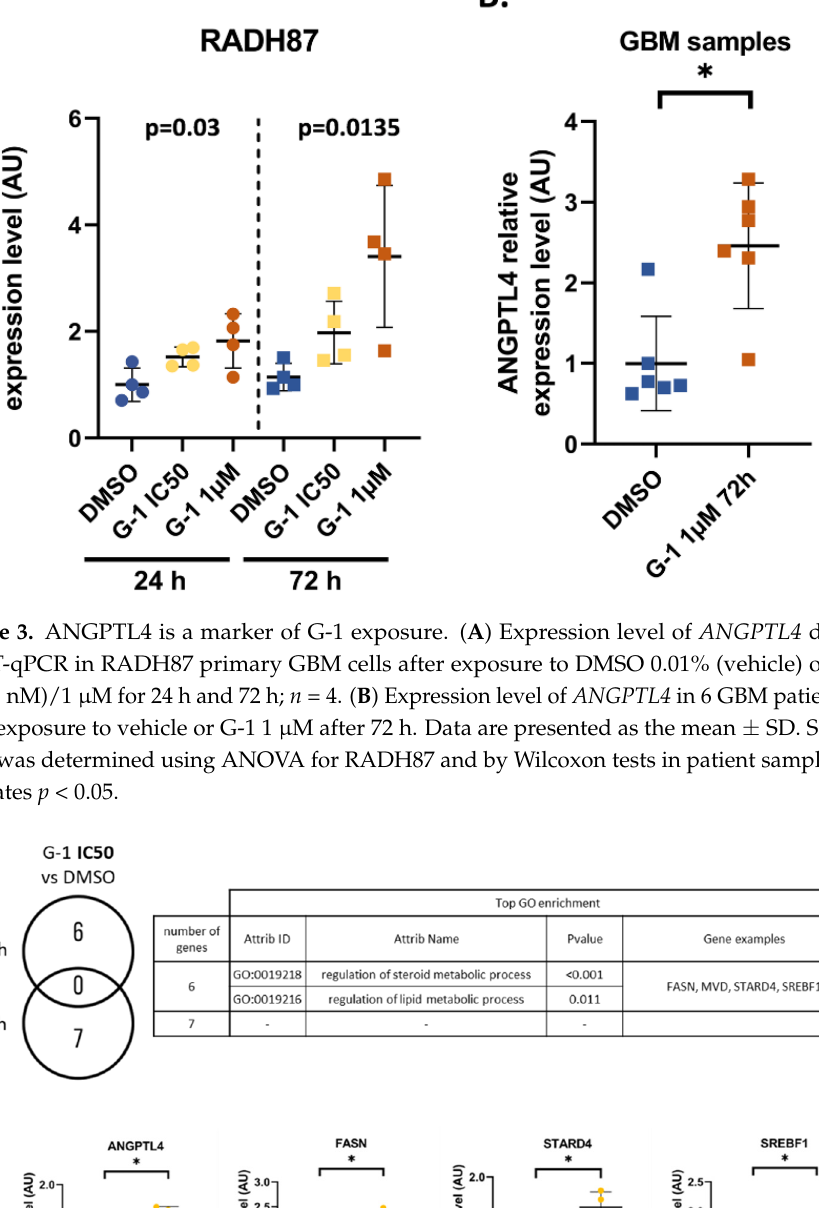
Figure 5. ( A ) Number of vehicle versus G-1 1 µM DEGs and table of associated functions at 24 h and 72 h. ( B ) Protein–protein interactions from the STRING interaction database. Among the 17 DEGs selected after 24 h exposure to G-1 1 µM, the cluster FADS1, FASN, LSS, LDLR, INSIG1, and STARD4 was identified. ( C ) RT-qPCR analysis of LDLR expression in the RADH87 primary GBM cell line after 24 h of G-1 1 µM exposure ( D ) Protein–protein interactions from the STRING interac- tion database. Among the 64 common DEGs selected after 24 h and 72 h exposure to G-1 1 µM, the cluster CDC20, PLK1, AURKA, and BORA was identified. ( E ) RT-qPCR analysis of PLK1 , BORA , AURKA , and CDC20 expressions in the RADH87 primary GBM cell line after 24 h of G-1 1 µM exposure. Data are presented as the mean ± SD. Significance level was determined using t -tests, where *** indicates p < 0.001, ** indicates p < 0.01, and * indicates p < 0.05; n = 4. In total, 1192 DEGs were identified after 72 h of 1 µM G-1 treatment (Table S7). No biological function was significantly enriched in this dataset when separating the 585 up- and 607 downregulated genes. As this total number of DEGs is not compatible with a